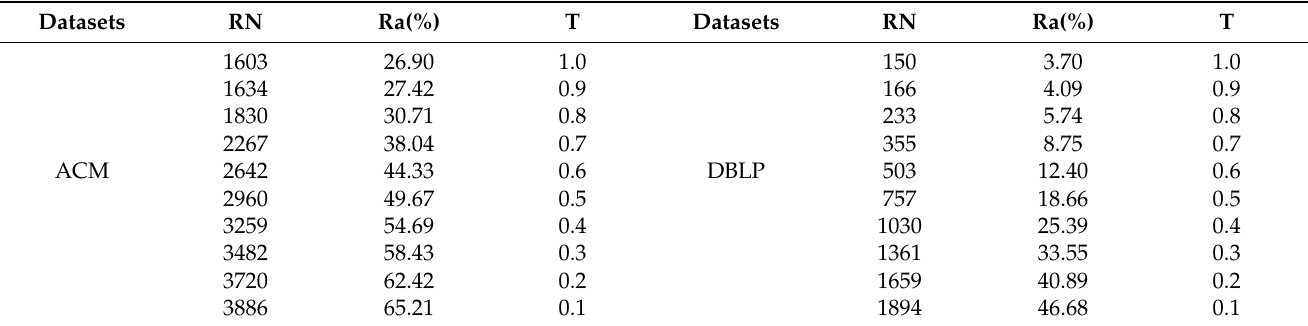
Table 3. Results of node reduction by trace equivalence. RN: number of nodes reduced, Ra: ratio of reduced nodes to the total number of nodes, T: